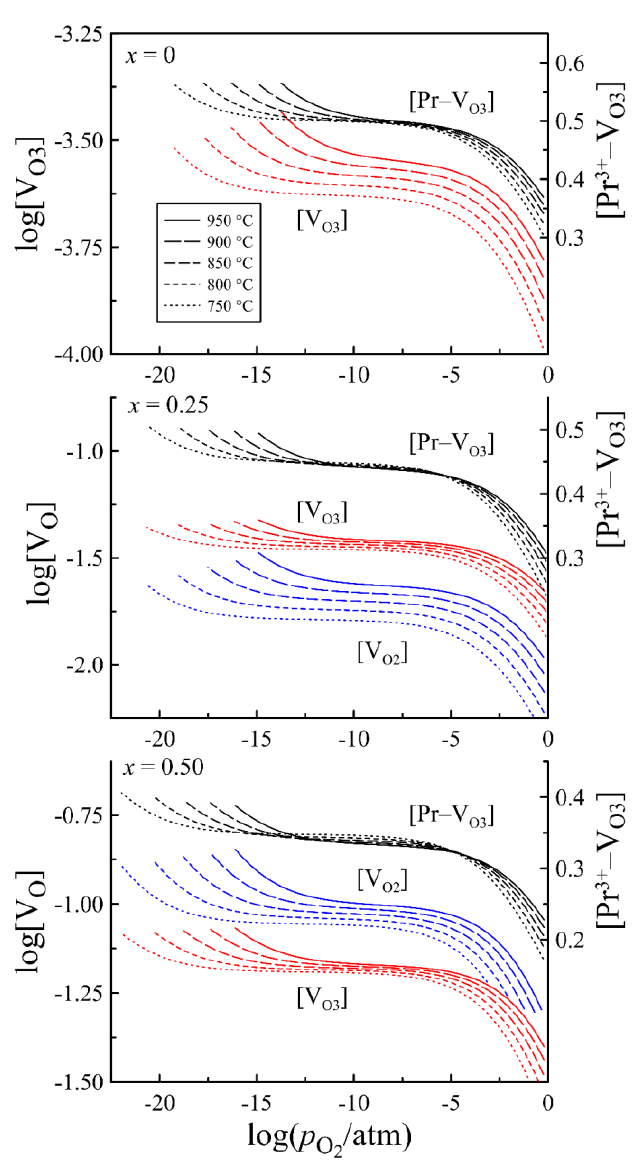
Figure 11. The concentration of free oxygen vacancies in O2 and O3 positions and clusters of [Pr 3+ – V O3 ] in PrBa 1− x Sr x Fe 2 O 6− δ as a function of oxygen partial pressure at different temperatures.